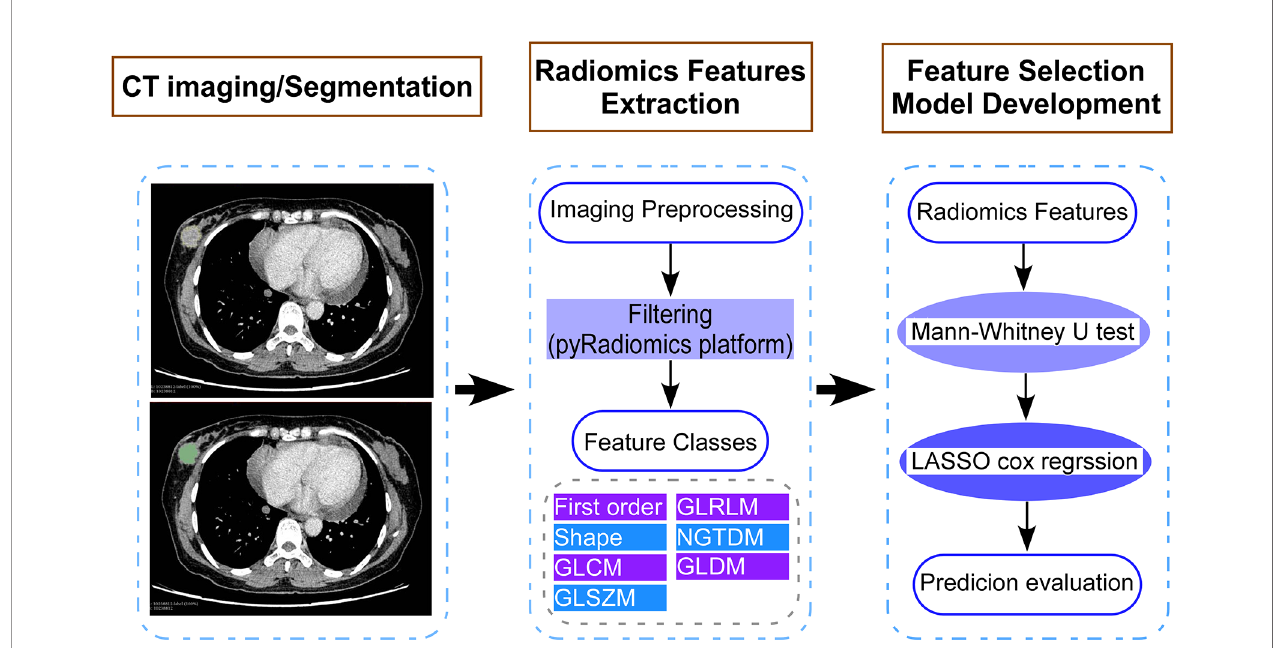
FIGURE 1 | Study fl ow diagram showing the development of a computed tomography (CT) imaging-based model for patients with breast cancer who had residual tumors after neoadjuvant chemotherapy. The steps include (1) CT image acquisition and segmentation, (2) extraction of features using the pyradiomics platform, and (3) selection of CT image features and construction of the model. LASSO, least absolute shrinkage and selector